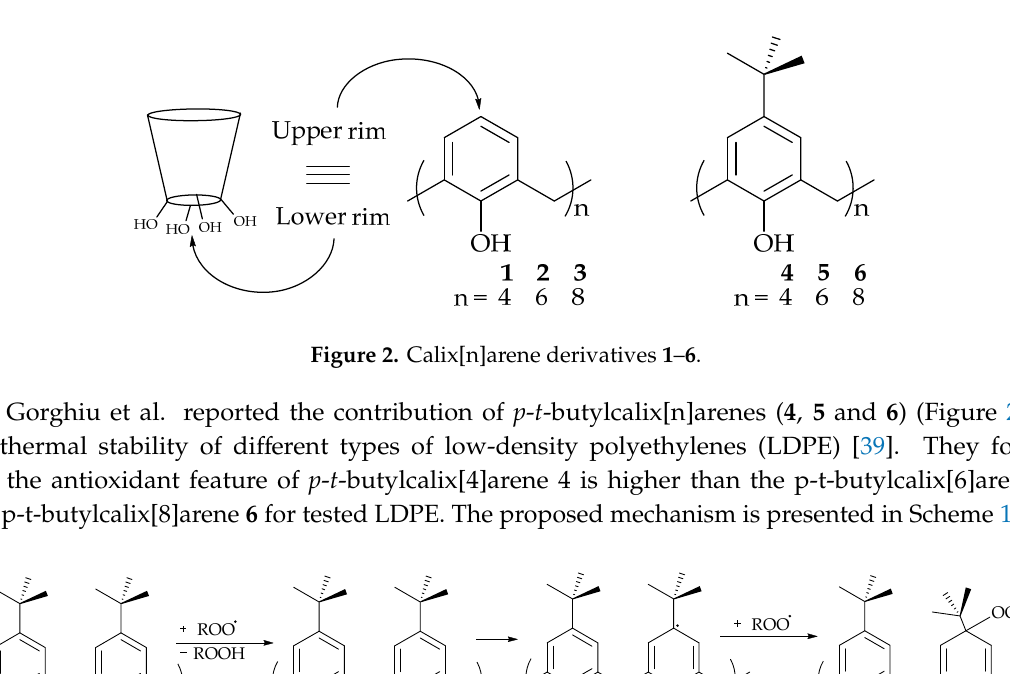
Figure 3. Structures of calix[4]arene derivatives 7 – 19 .